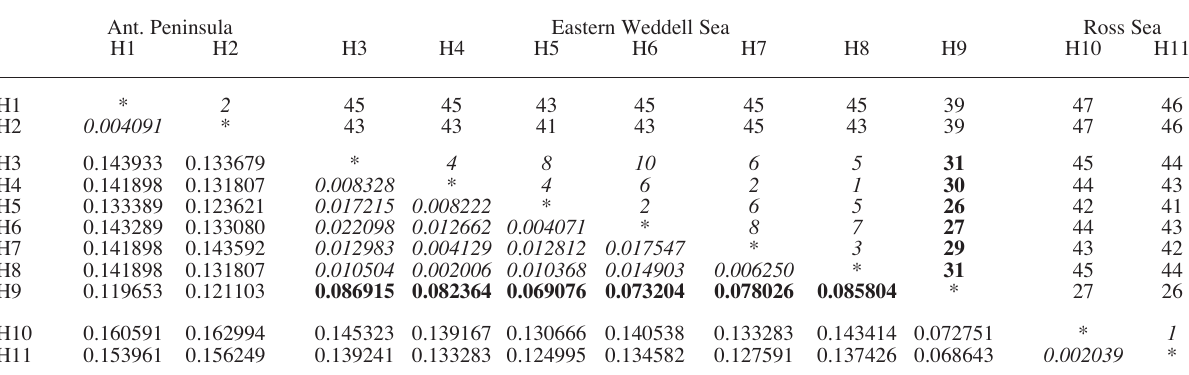
ABLE 2. – Maximum-likelihood estimates of pairwise genetic distances (lower triangle) and observed genetic distances (upper triangle) between the 11 unique mitochondrial haplotypes in the LSU gene of Glyptonotus in this study. The specimens and sampling localities of each haplotype are given in Table 1. Details about the LRT and the model used are described in the text. Observed distance values should be regarded as rough approximations only because no corrections for multiple substitutions are made. Lower variability within sampling regions was indicate in italics and the higher divergence of haplotype H9 in bold